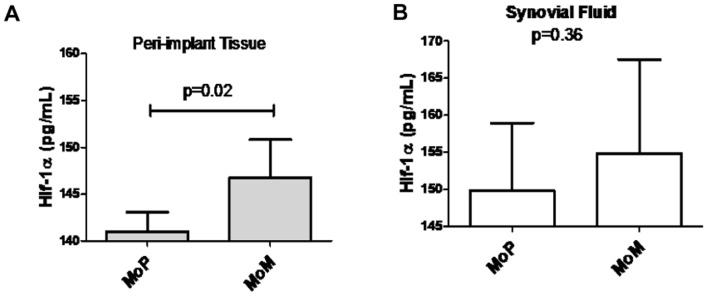
Total HIF-1α protein expression in vivo.(A) The expression level of total HIF-1α protein in peri-implant patient homogenized tissue samples of metal-on-metal (MoM) (n = 5) and metal-on-polythetheylene (MoP) (n = 10) implants and quantified with the Human/Mouse Total HIF-1α DuoSet IC ELISA. (B) The expression level of total HIF-1α protein in synovial fluid patient samples of metal-on-metal (MoM) (n = 4) and metal-on-polythetheylene (MoP) (n = 5) implants and quantified with the Human/Mouse Total HIF-1α DuoSet IC ELISA. Note: * p<0.05 determined by Student's t-test.